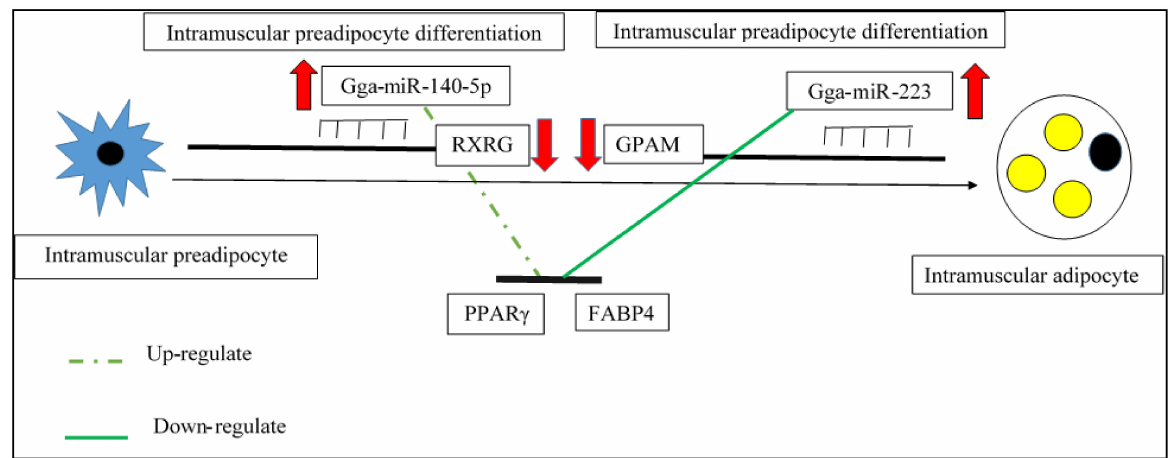
Figure 3. Differentially expressed miRNA through chicken intramuscular preadipocyte differentiation in the breast muscle between juvenile and late-laying hen. Overexpression of gga-miR-140-5p reduced the expression of retinoid X receptor γ (RXRG) while upregulated the expression of adipogenic markers, including the peroxisome proliferator-activated receptor γ (PPAR γ ) and fatty acid-binding protein 4 (FABP4); promoting intramuscular preadipocyte differentiation and IMF deposition in chickens [7]. Controversy, overexpression of gga-miR-223, as a negative regulator of chicken intramuscular preadipocyte differentiation, significantly reduced the expression of its target gene glycerol-3-phosphate acyltransferase (GPAM), as well as PPAR γ and FAPB4, and lead to intramuscular preadipocyte differentiation inhibition and decrease the number of IMF droplets in the adipocyte